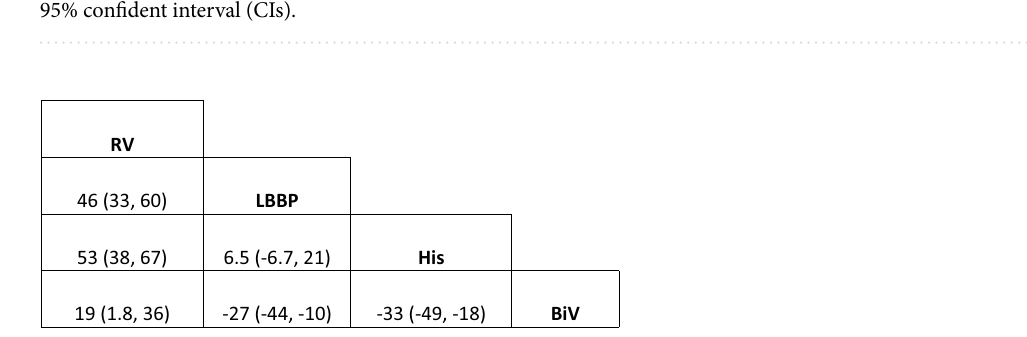
Figure 3. League tables showing the results of the network meta-analyses comparing the QRS duration between RV pacing, Left bundle branch pacing, His bundle pacing and Biventricular pacing. Mean difference between type of pacing and 95% CI. Mean difference less than 1 means the top-left treatment is better, in terms of QRS interval reduction with pacing compared to the